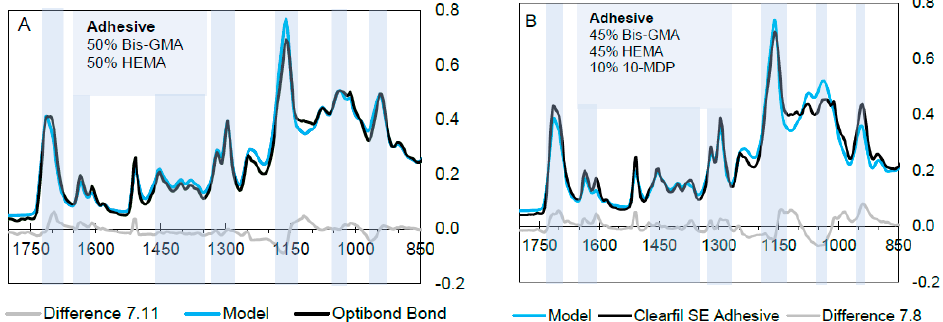
Figure 7. FTIR spectra of primers, the calculated model spectra, and difference between the actual spectra and model. OBFL adhesive ( A ) contains 50% Bis-GMA and 50% HEMA. Level of GDMA was too low to detect. CFSE’s adhesive ( B ) right figure, the model has an equal mixture of Bis- GMA/HEMA. Blue lines highlighted represent common methacrylate peaks.